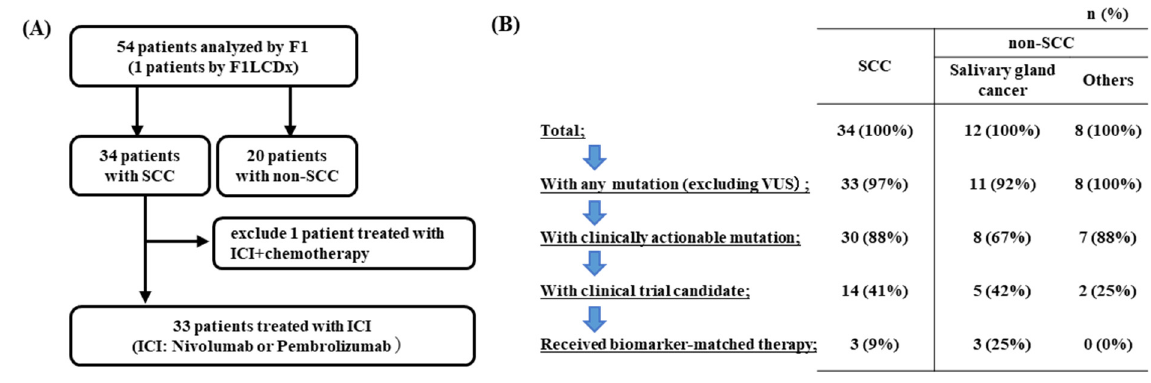
Figure 1. Total population and clinical utility of CGP in the C-CAT database. ( A ) C-CAT database included genomic information for the F1(F1CDx or F1LCDx) test and NCC Oncopanel test. Infor- mation of 29,490 patients was registered in C-CAT, with a total of 1119 patients diagnosed with R/M HNC. ( B ) Percentage of patients with access to treatment for comprehensive genomic profiles. VUS, a variant of uncertain significance.